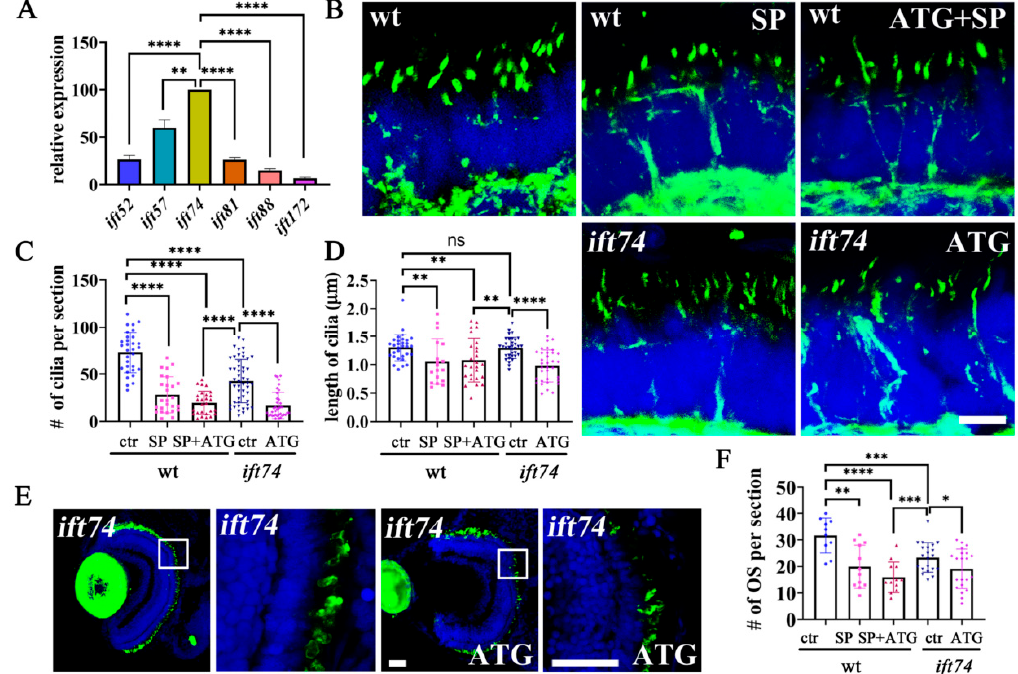
Figure 6. Maternal Ift74 contributes to the slow photoreceptor degeneration. ( A ) qRT-PCR results showing relative expres ‐ sion level of ift ‐ b genes in one ‐ cell stage embryos. The expression of the ift74 gene was set as 100%. ( B ) Confocal images showing photoreceptor connecting cilia in the retinae of 5 dpf wild ‐ type, ift74 morphants, and mutant larvae. Cilia were stained with anti ‐ acetylated alpha tubulin antibody (green). ( C , D ) Dot plots showing the number and length of connecting cilia in different groups as indicated. ( E ) Confocal images showing rod outer segments visualized with zpr ‐ 3 antibody in 5 dpf ift74 mutants injected with control or ATG morpholino as indicated. Enlarged views of the boxed area are shown on the right. ( F ) Statistical results showing the number of outer segments per retina section in different groups as indicated. Scale bars: B, 5 μ m; E, 30 μ m. * p < 0.05, ** p < 0.01, *** p < 0.001, **** p < 0.0001, ns, no significant.